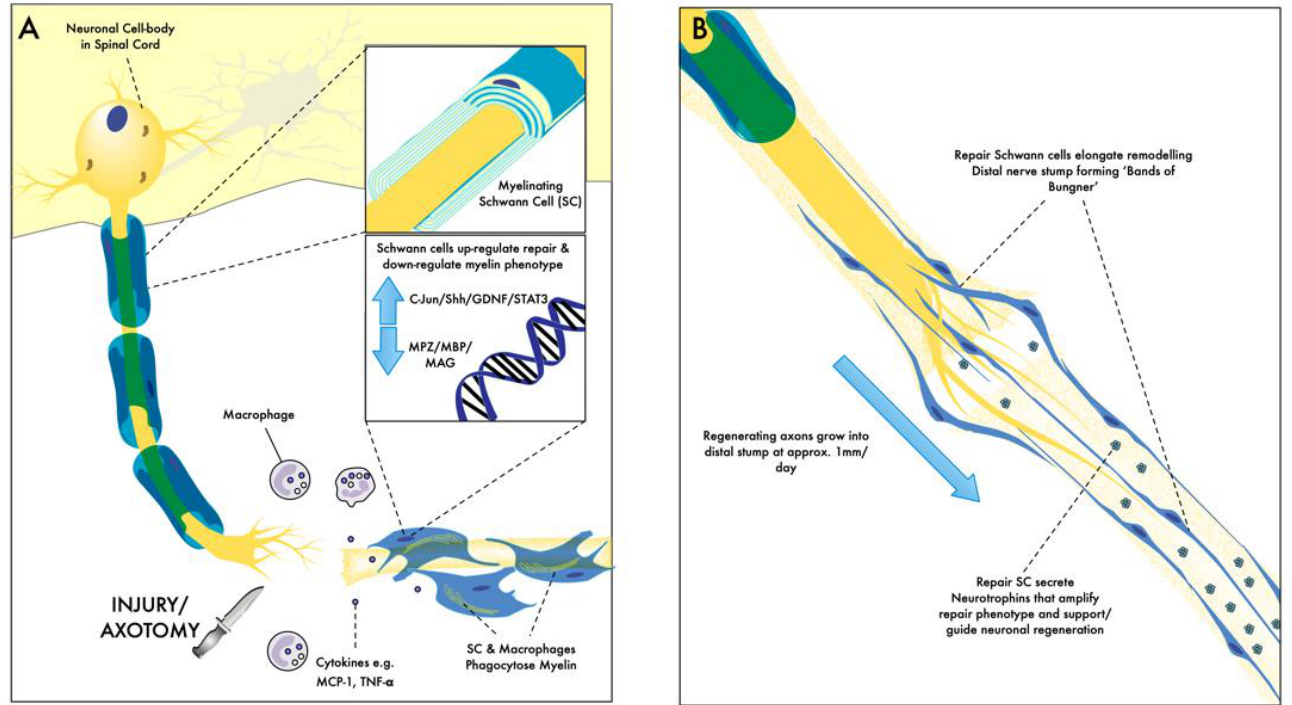
Figure 1. ( A ) Following axotomy, SC undergo a phenotypic switch to a repair phenotype. This switch involves the suppression of genes associated with myelination, e.g., MPZ/MBP/MAG, and the upregulation of c-Jun/Shh/GDNF/STAT3, which initiate the repair phenotype. In this state, SC initiate an immune response through the release of cytokines (e.g., TNF- α ) and monocyte chemotractants (e.g., MCP-1). They activate macrophages and alongside macrophages phagocytose myelin. ( B ) The activation of c-Jun in SC initiates considerable morphological changes with extensive elongation forming the bands of Büngner, remodelling the distal stump, and bridging nerve gaps. Concurrently, they secrete neurotrophins to support and guide axonal regeneration. With chronic denervation and over time, this repair phenotype is ultimately lost.